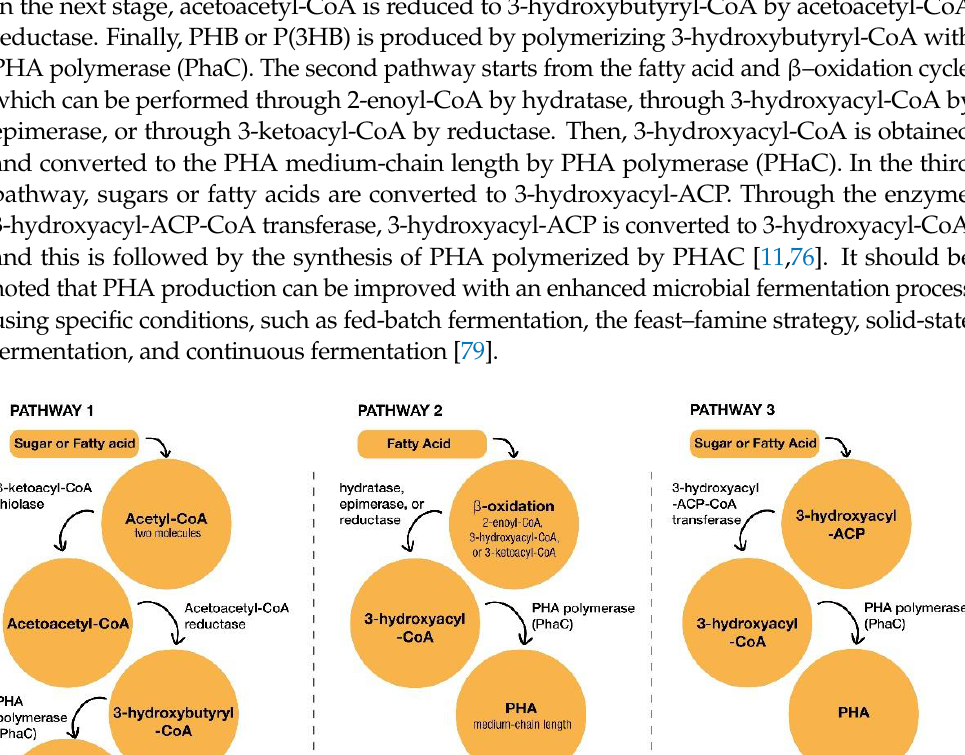
Figure 4. Challenges related to PHA production from SCG.